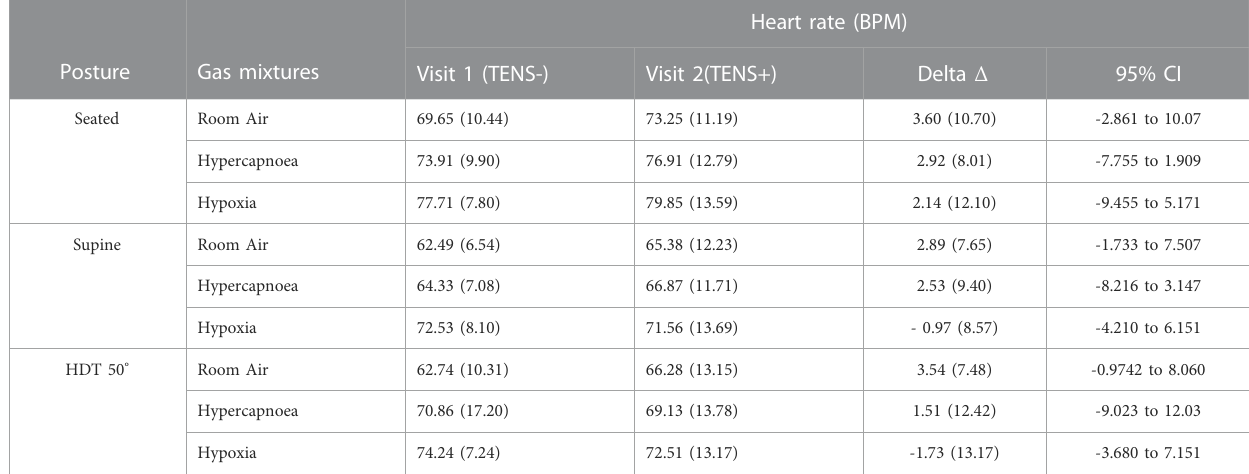
TABLE 5 Heart rate with and without electrical stimulation in seated, supine and HDT postures. Data are presented as mean (SD). HDT, head down tilt. TENS-, electrical current off. TENS + electrical current turned on. CI, 95% con fi dence interval.